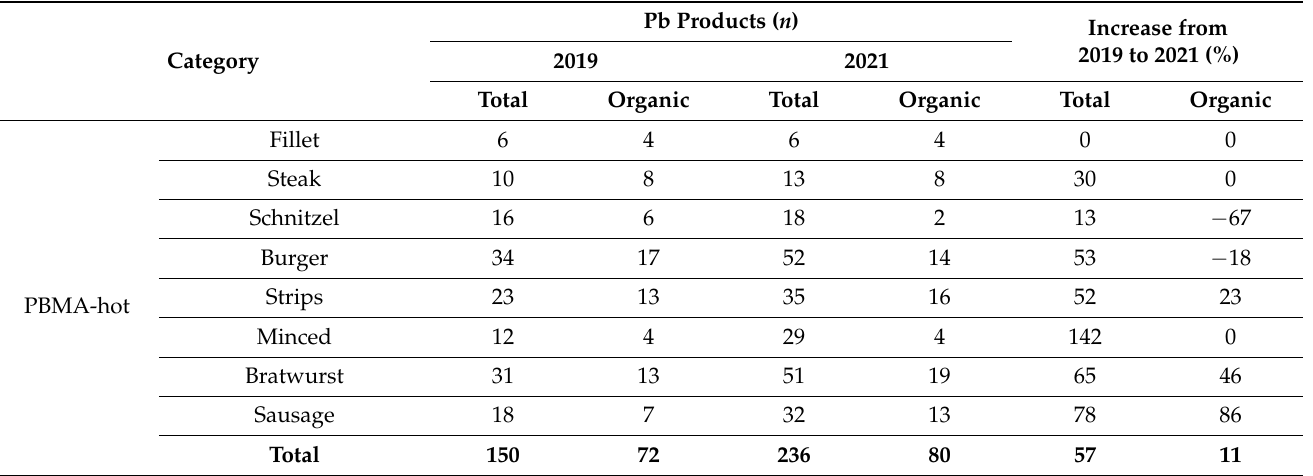
Table 3. Development of the number and type of products of pb cheese and meat alternatives, and the distribution (%) of products with organic labels between 2019 and